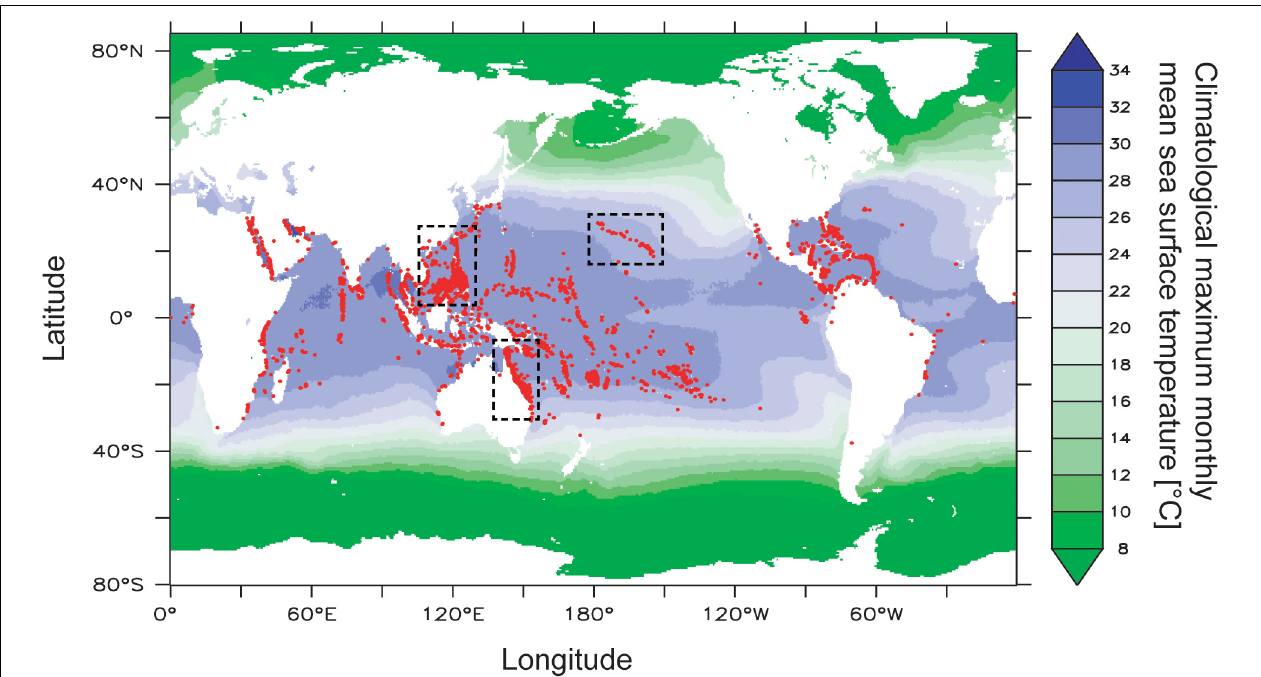
FIGURE 1 | Map containing grid cells in which artificial upwelling (AU) has been implemented (marked with black boxes), overlaid onto the maximum monthly mean (Max-MM) sea surface temperature (SST) based on 1985–1993 climatology data. Max-MM SST data was downloaded from Coral Reef Watch (https://coralreefwatch.noaa.gov/satellite/hdf/index.php), and the coral reef locations, marked as red spots, were obtained from ReefBase